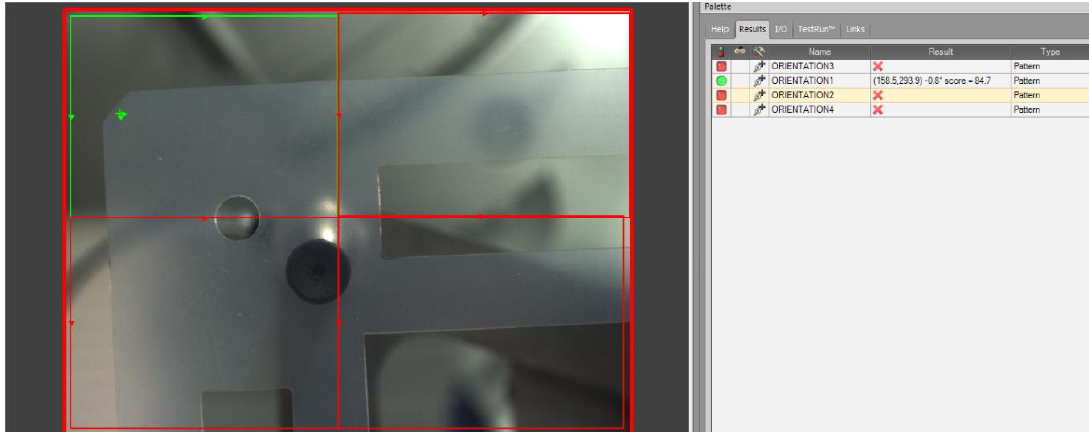
Figure8. Imageanalysisresultshowingidentificationofthechamferedgasketcornerinthefirstposition. Energies 2019 , 12 , x FOR PEER REVIEW Figure 8. Image analysis result showing identification of the chamfered gasket corner in the first position.